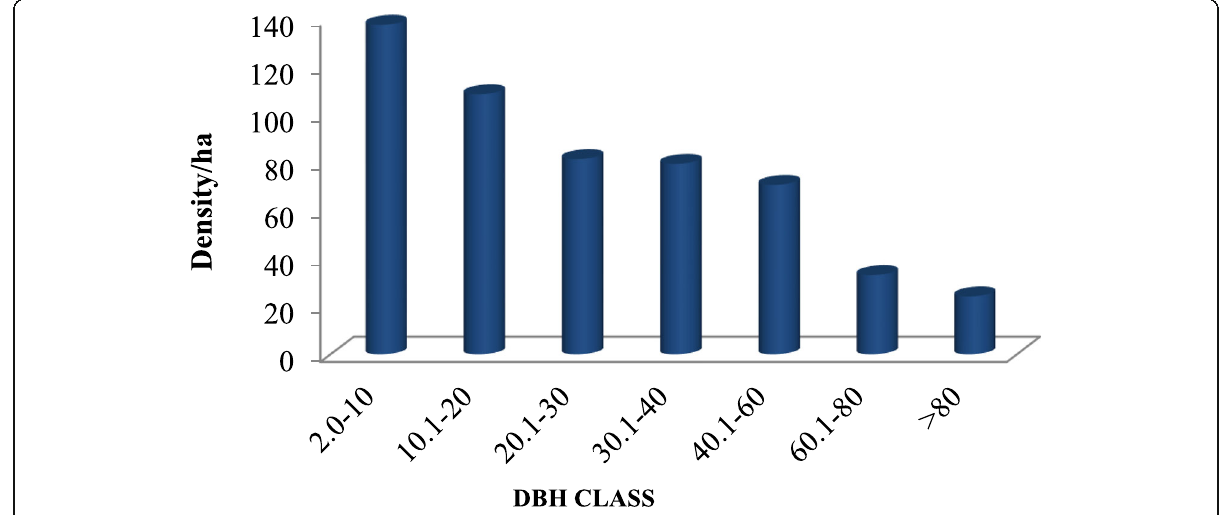
Fig. 5 DBH class distributions of trees and shrubs in the Hirmi